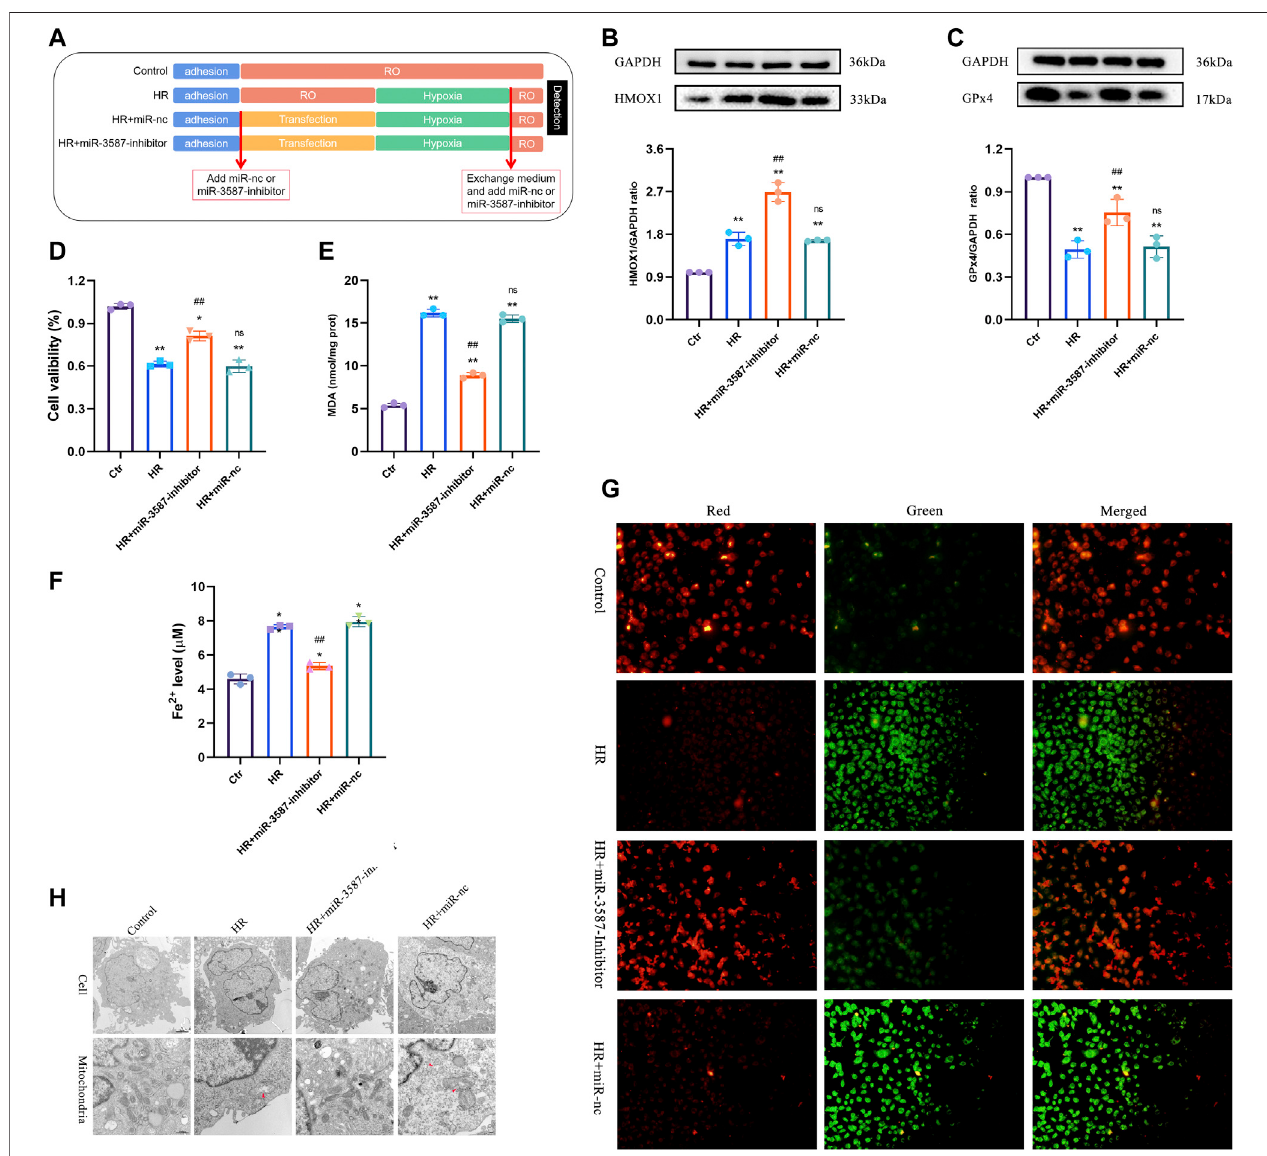
FIGURE4| InhibitionofferroptosisinNRK-52EcellsduringHRviathemiR-3587-mediatedregulationofHMOX1. (A) Experimentalgroupingandsampleprocessing. (B) HO-1proteinbanddensitometricanalysis. (C) GPX4proteinbanddensitometricanalysis. (D) Cellviabilitytestresults. (E) MDAlevelmeasurements. (F) Fe 2+ leveltest. (G) Mitochondrial membrane potential was measured using JC-1 in different treatment groups. * p < 0.05; ** p < 0.01 vs. control group. ## p < 0.01; ns, p > 0.05 vs. HR group. (H) Transmissionelectronmicrographshowingmorphologicalchangesinmitochondria.Abbreviations:HR,hypoxia-reoxygenation;RO,reoxygenation;miR- nc, microRNA negative control; miR-3587, microRNA-3587; Ctr, control; HMOX1, heme oxygenase 1; GPX4, glutathione peroxidase 4; MDA,